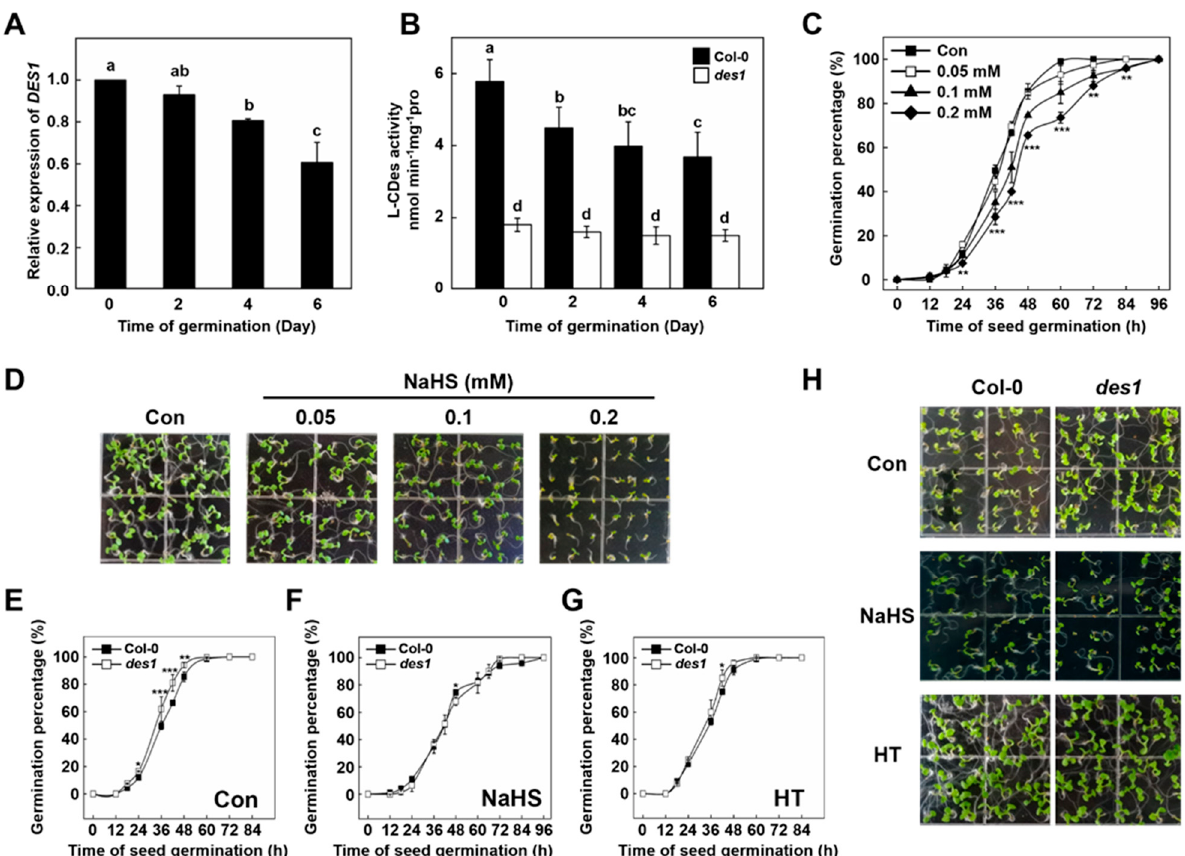
Figure 1. The inhibitory effect of H 2 S on the seed germination and post-germination of Arabidopsis thaliana . ( A ) Time-course changes of relative expression of DES1 in wild-type (Col-0) Arabidopsis seedlings. Arabidopsis seeds were incubated on 1 / 2 MS medium. Afterward, the relative expression of DES1 was determined at the indicated time points after germination. Expression levels are presented relative to that of UBQ10 , with DES1 expression in the 0-day set to 100%. ( B ) Time-course changes of L-CDes activity in wild-type (Col-0) and des1 germinating seeds. L-CDes activity was determined at the indicated time points after germination. ( C ) Time-course changes of germination percentage in Col-0 Arabidopsis seedlings upon NaHS treatment. Arabidopsis seeds were incubated on 1 / 2 MS medium containing 0 (control), 0.05, 0.1, or 0.2 mM NaHS, respectively. The germination percentage (%) of seeds was counted at the indicated time points. Con: control. ( D ) Photographs of wild-type Arabidopsis seeds germinated seeds five days after the initiation of germination on 1 / 2 MS medium containing NaHS (0, 0.05, 0.1, 0.2 mM). ( E – G ) Time-course changes of germination percentage in Arabidopsis seedlings upon NaHS or HT treatment. ( H ) Photographs of germinated seeds of wild-type and des1 five days after the initiation of germination on 1 / 2 MS medium containing NaHS (0.1 mM) or HT (1 mM). HT: hypotaurine. Data are mean ± SE of three independent experiments with three biological replicates for each individual experiment. Bars with different letters indicate significant differences at p < 0.05 according to one-way ANOVA (post-hoc Tukey’s HSD test). Asterisks represent significant differences between treatments according to Student’s t -test (* p < 0.05, ** p < 0.01, *** p < 0.001).